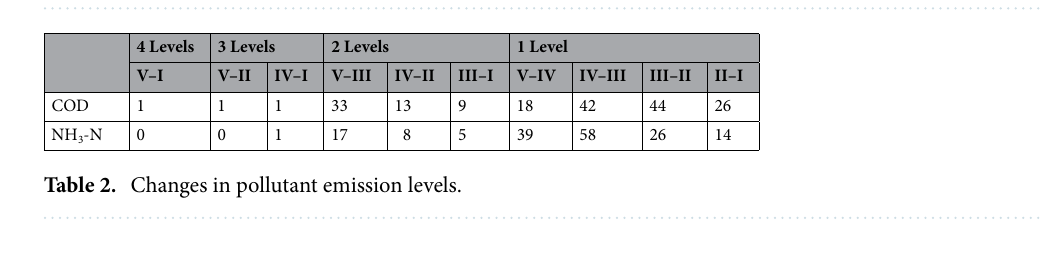
Figure 2. Classification of counties by COD ( a,b ) and NH 3 -N ( c,d ) emissions. Map was generated by ArcGIS 10.2 (http:// www. esri. com/ softw are/ arcgis/ arcgis- for- deskt op).